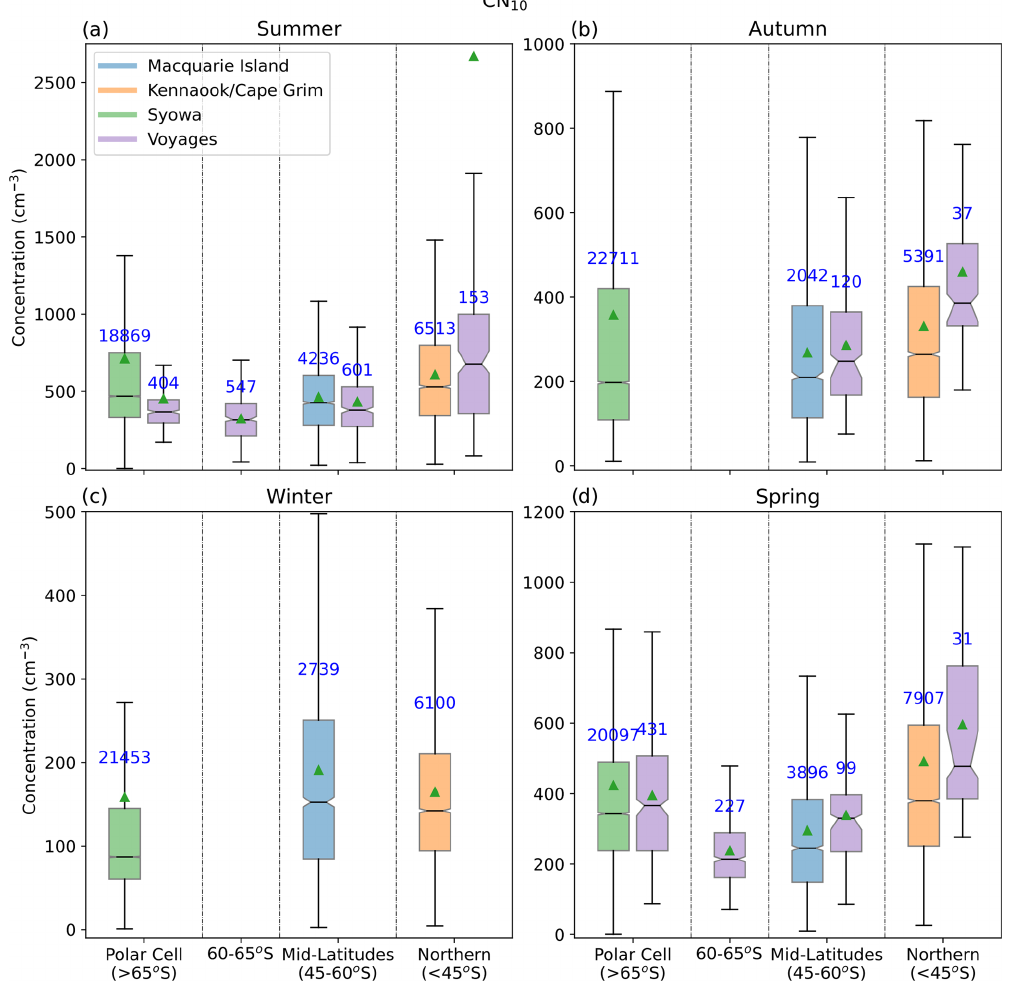
Figure 4. Box plots of CN 10 concentration categorised into seasons and latitudinal sectors in line with definitions by Humphries et al. (2021a). The 60–65 ◦ S sector is divided out as this is a boundary zone, the latitude of which varies significantly on daily timescales. All voyages are combined into a single data set (shown in purple). Box plots are standard Tukey plots with the boxes representing the 25th, 50th and 75th quartiles and the upper (lower) whisker being the first data points above (below) the 75th (25th) quartile plus (minus) 1.5 times the interquartile range. The notch in the box represents the confidence interval of the median, as calculated from 1000 bootstrap iterations. Green triangles represent the mean of each data set and the numbers above each box show the number of hourly observations used to calculate each box plot. A similar figure is shown in Fig. A6 with all y axis limits kept the